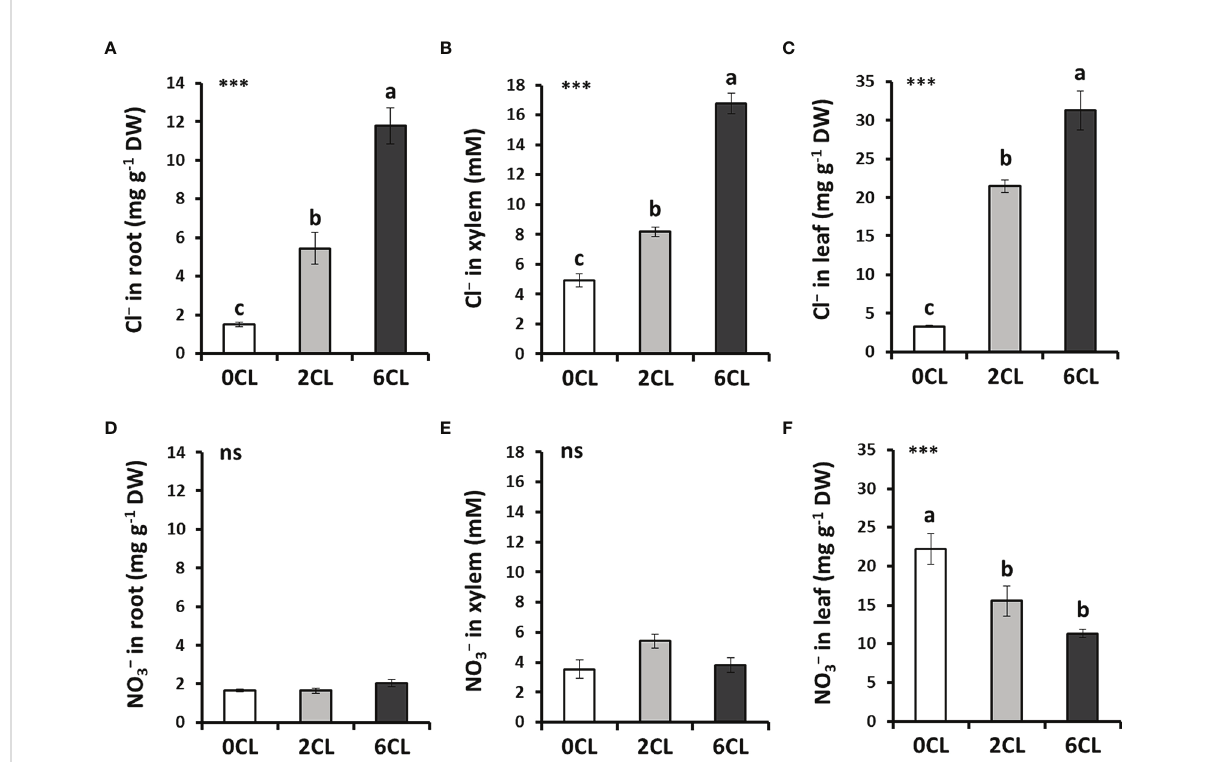
FIGURE 2 Effect of Cl − nutrition on anion content in different plant tissues. Tobacco plants were treated with 0, 2 and 6 mM of Cl − salts (CL), and supplemented with a mix of sulphate+phosphate salts to maintain a similar cationic balance. Cl − (A-C) and NO − 3 (D – F) contents are shown in roots, xylem sap and fully-expanded intermediate leaves, respectively. Mean values ± SE, n =6-12. Statistics was calculated through ANOVA, where mean values with different letters are signi fi cantly different according to Tukey ’ s test at P ≤ 0.05. Levels of signi fi cance: *** P ≤ 0.001 and ‘ ns ’ P > 0.05. DW, dry